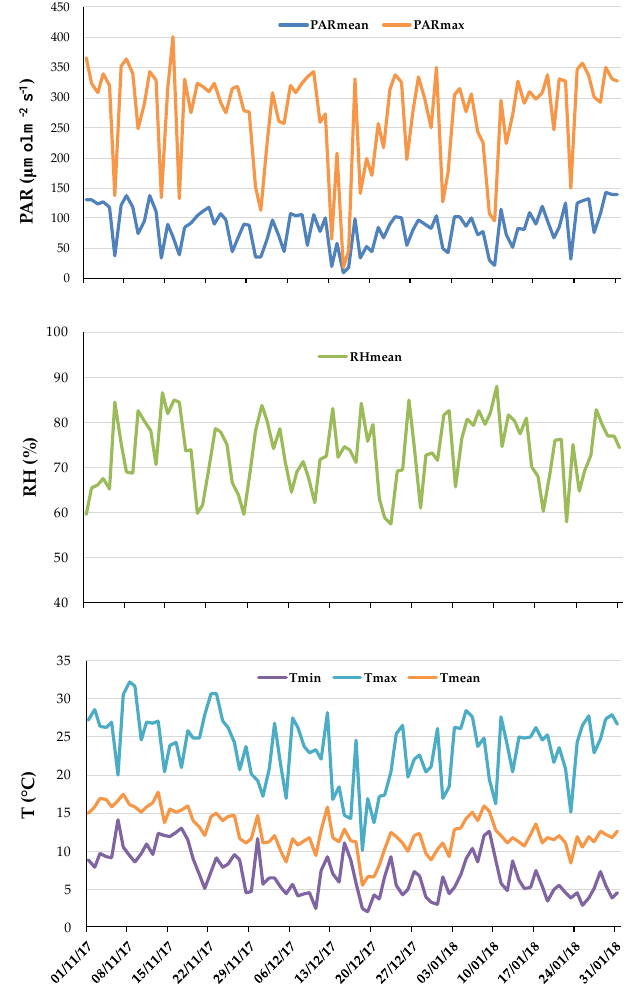
Figure 1. Photosynthetically Active Radiation (PAR), Relative Humidity (RH), average mean, minimum (min) and maximum (max) air temperatures (T), inside the greenhouse during the experiment.